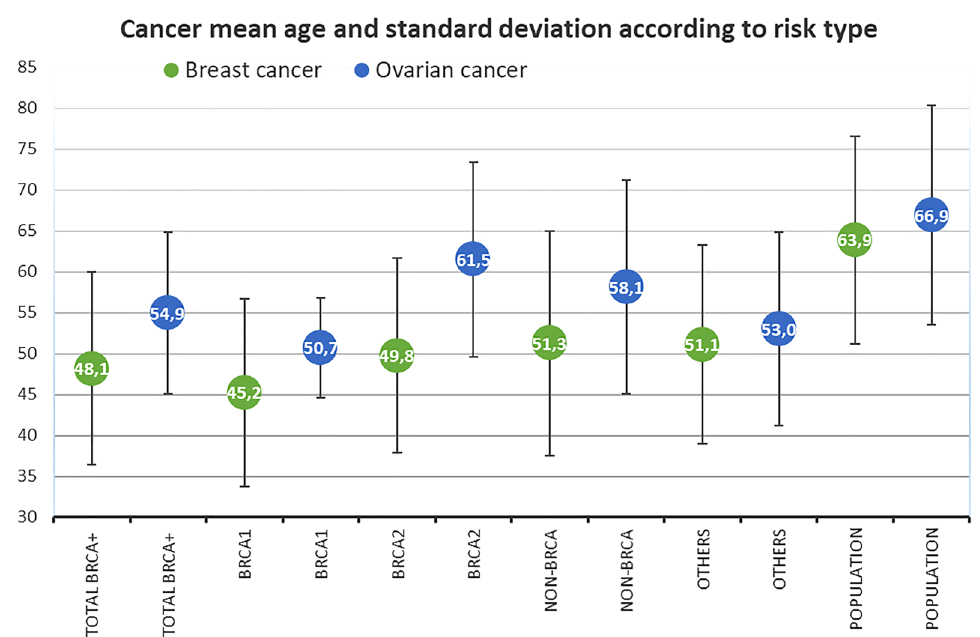
Figure 1. Cancer mean age and sample standard deviation in BRCA -families, non- BRCA families with high risk, other families and Finnish